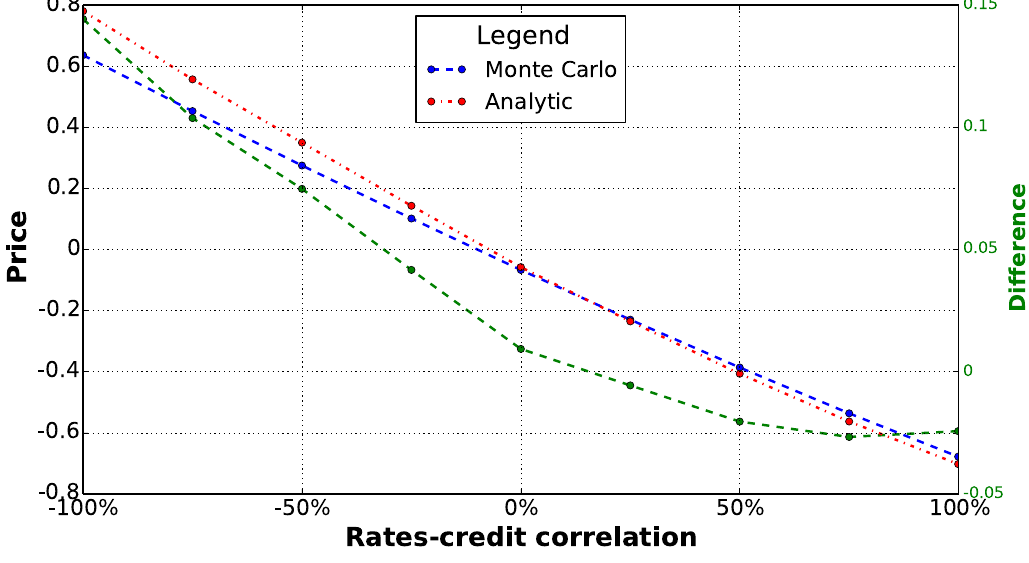
Figure 2. PV dependence of interest rate swap protection on rates–credit correlation